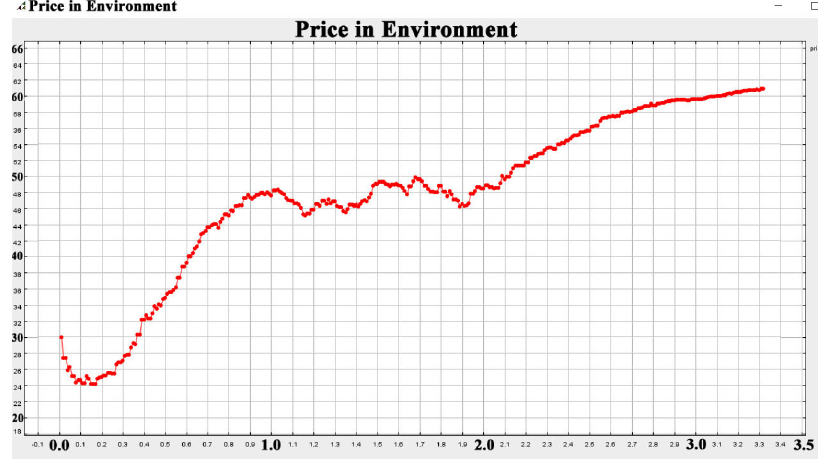
Figure 7. Market price curve – private chain